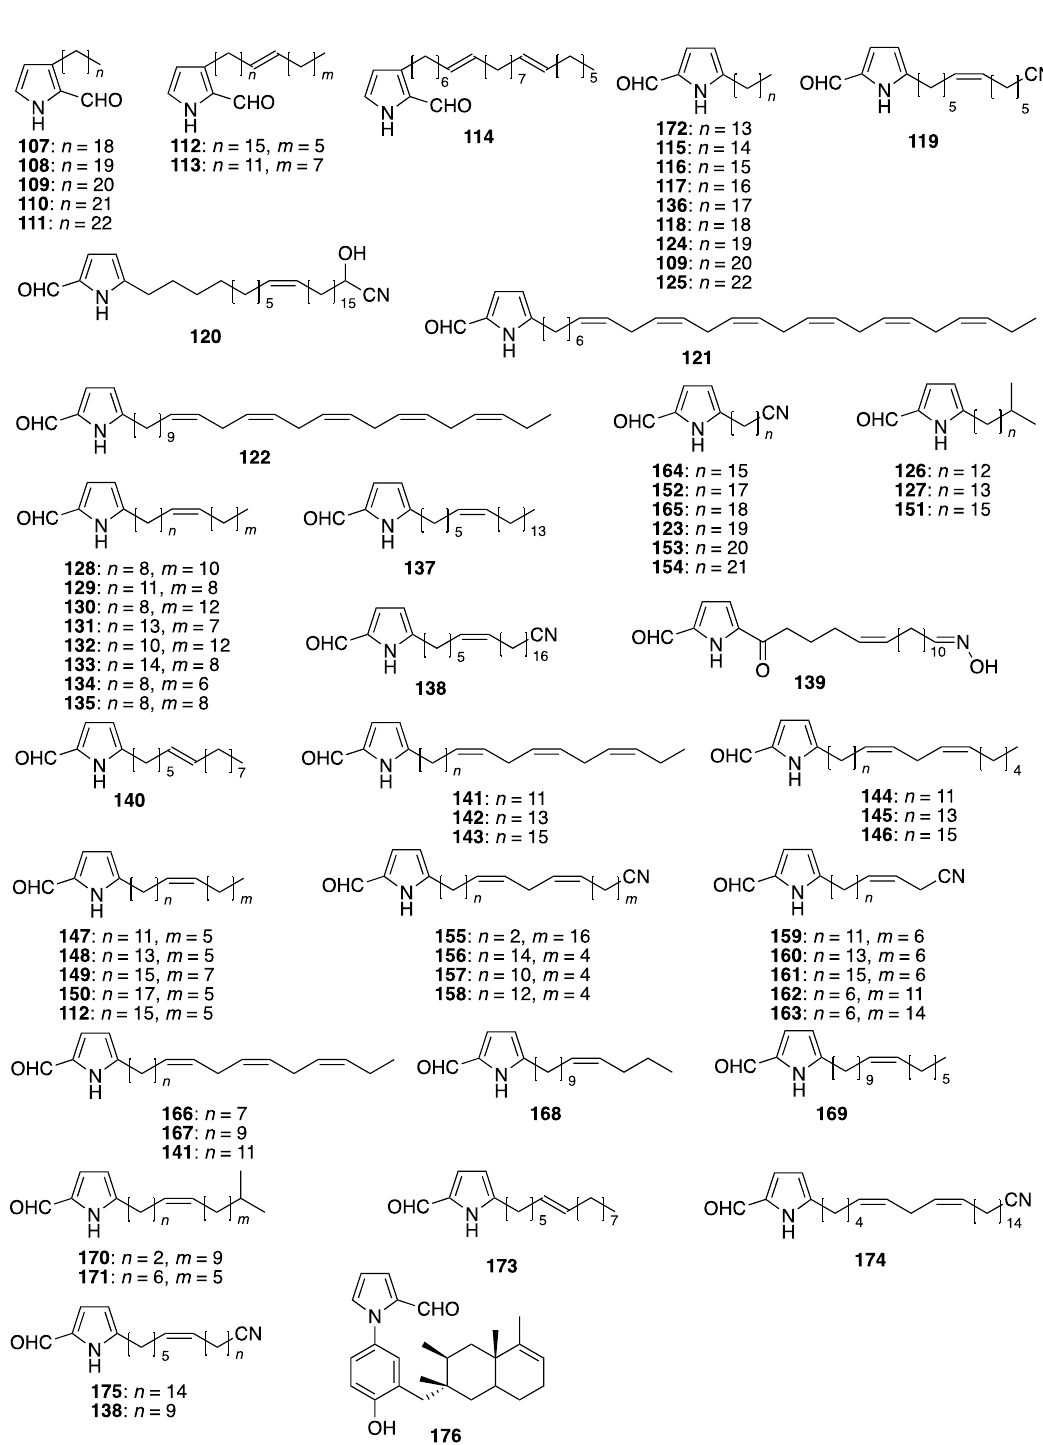
Figure 5. Structures of Py-2-Cs from microorganisms. In 2014, seven new compounds, including five new Py-2-Cs ( 177 – 181 , jiangrines A– E, along with the pyrrolezanthine, 10 ) were isolated from an Actinobacterium, Jiangella gansuensis . The structures of the compounds were determined mainly based on NMR spec- troscopic techniques (COSY, HMBC, and NOE,) and HRESIMS. The precise stereochemical configuration of the glycerol moiety at the 5-position of the pyrrole ring was determined based on the chemical reaction in which the hydroxyl group at the 2-position of